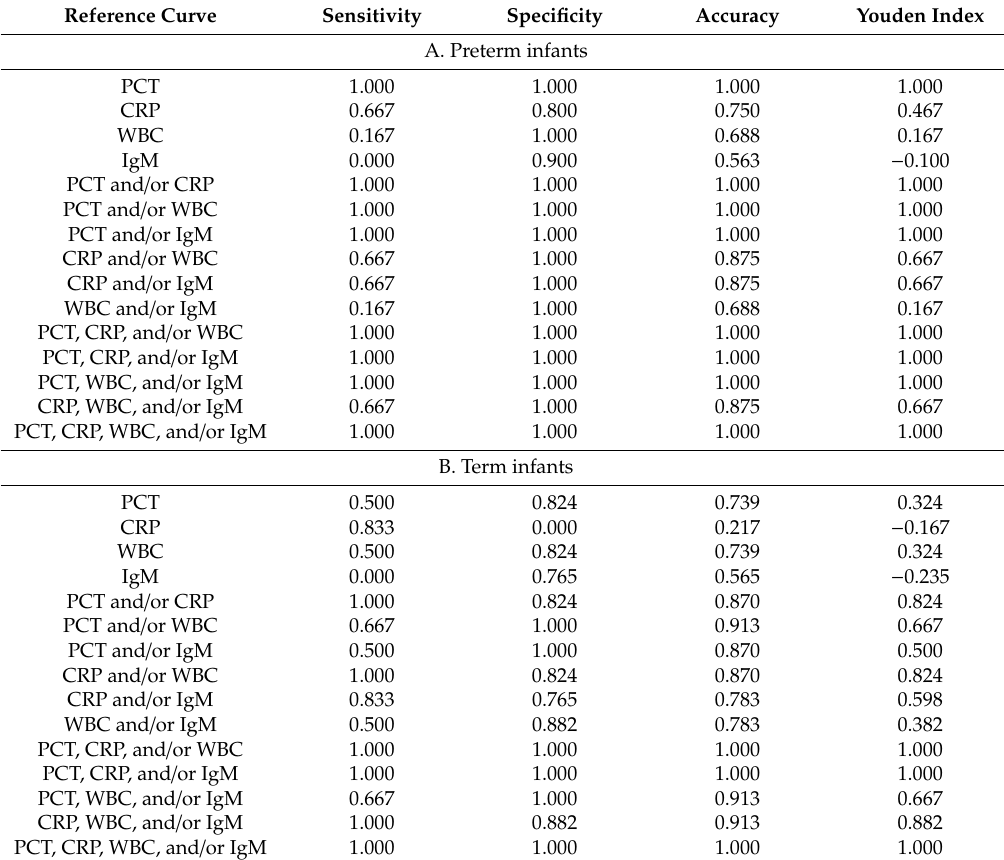
Table 6. Comparisons among the four biomarkers, alone or in